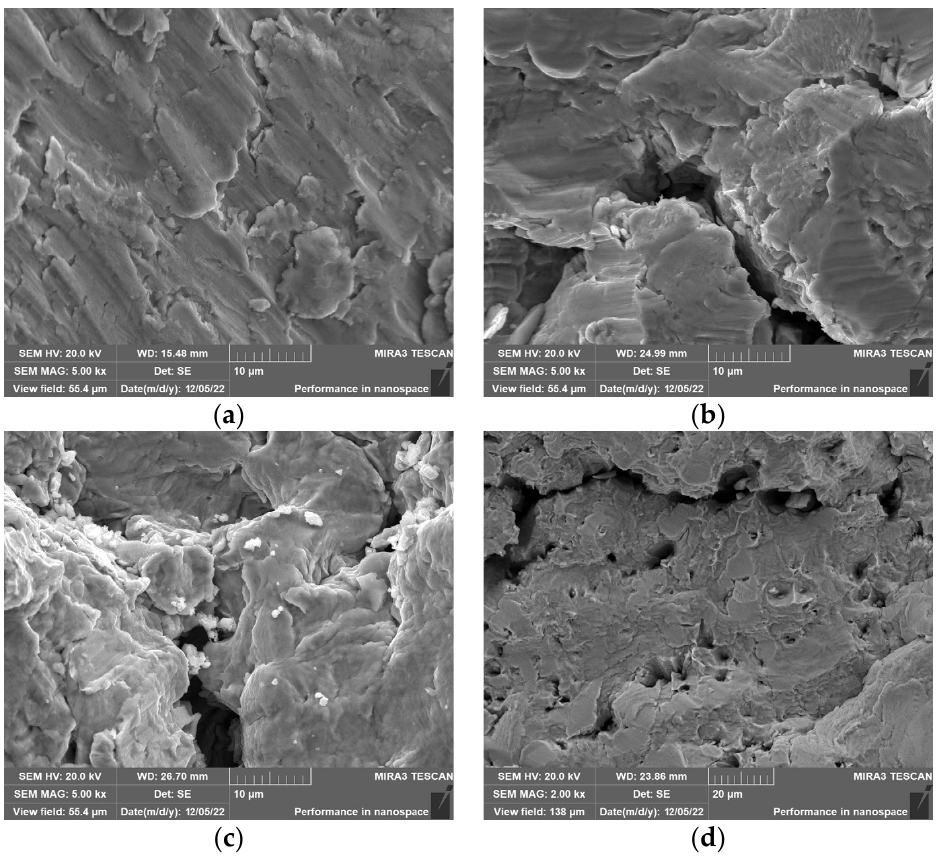
Figure 8. Center morphology of 316L stainless steel fatigue fractures in different environments: ( a ) air; ( b ) 2wt% NaCl solution; ( c ) 5wt% NaCl solution; ( d ) 8wt% NaCl solution. The scale in ( d ) is 20 μm.